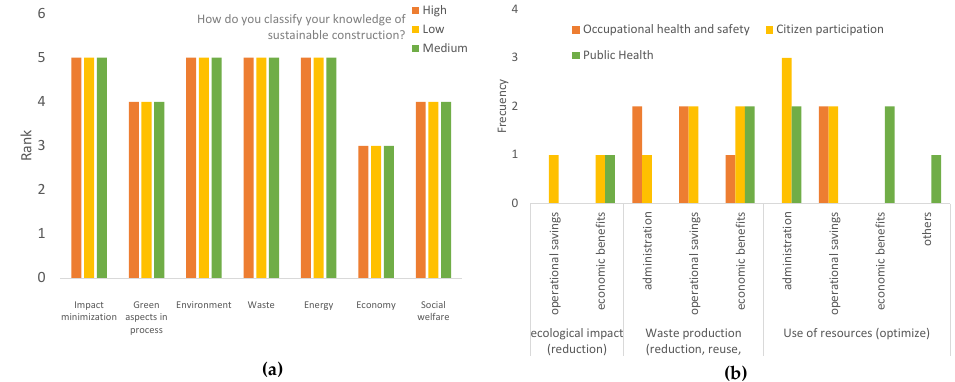
Figure 12. Results for: ( a ) attributes considered the most important for defining sustainability in construction and ( b ) the most important aspects considered to achieve sustainable